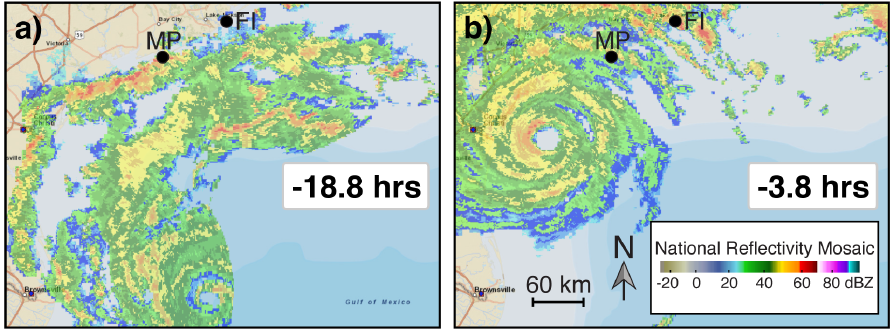
Figure 9. NEXRAD radar reflectivity mosaics from NOAA depicting land-falling tropical cyclone rainbands (TCRs) offshore both field sites ( a ) coincident with the initiation of coastal flooding in the backshore at Matagorda Peninsula (“MP”, Figure 4b) and ( b ) just prior to the peak water level at MP (Figure 6). Atmospheric disturbances accompanying TCRs can trigger meteotsunami in the GOM, and it is hypothesized that VLF fluctuations at both field sites are